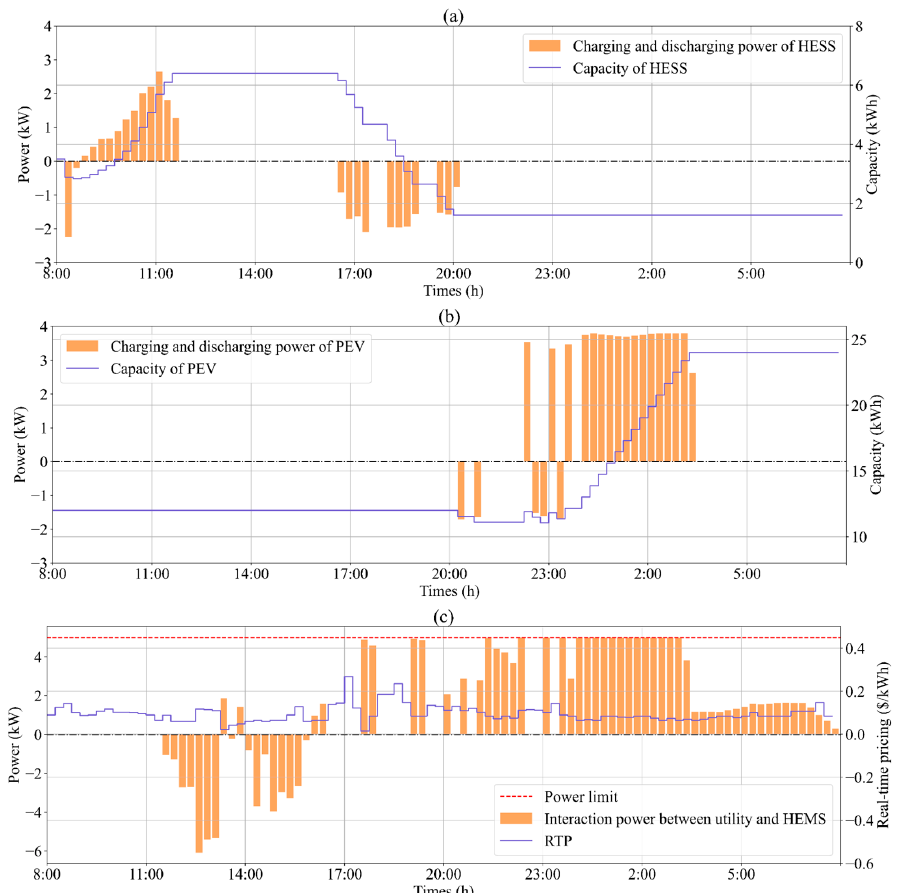
Figure 12. Load profiles for ( a ) HESS in HESS2H mode, ( b ) PEV in V2H mode, and ( c ) H-MG without mode segmentation strategy.